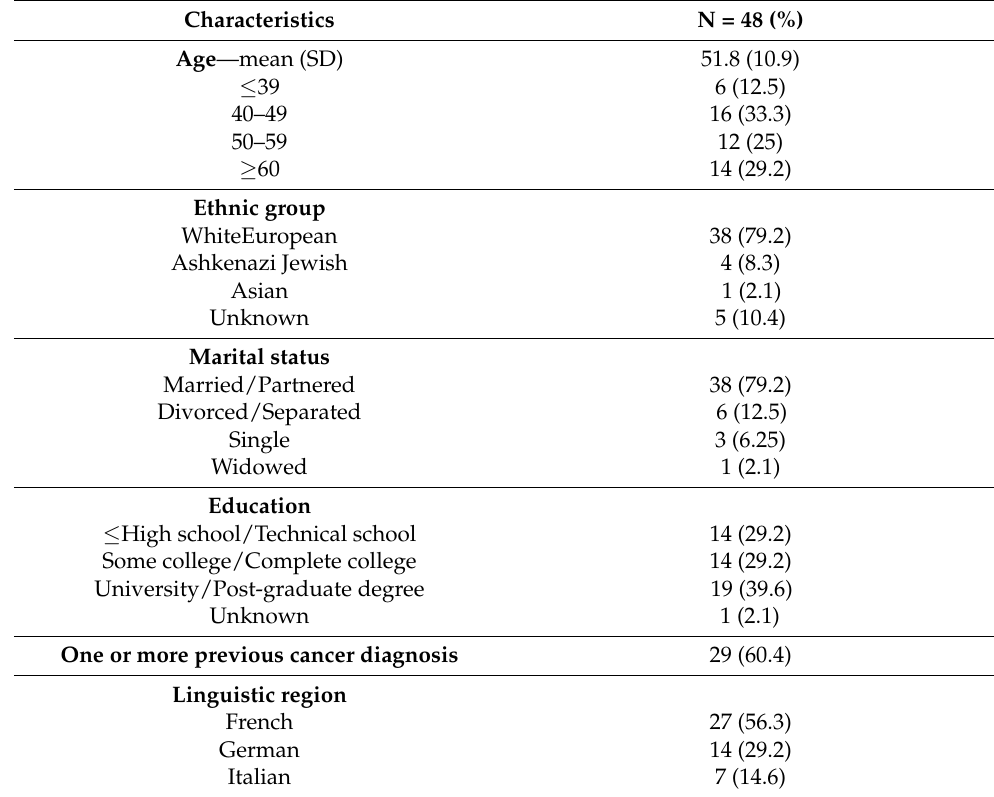
Table 1. Socio-demographic and clinical characteristics of the